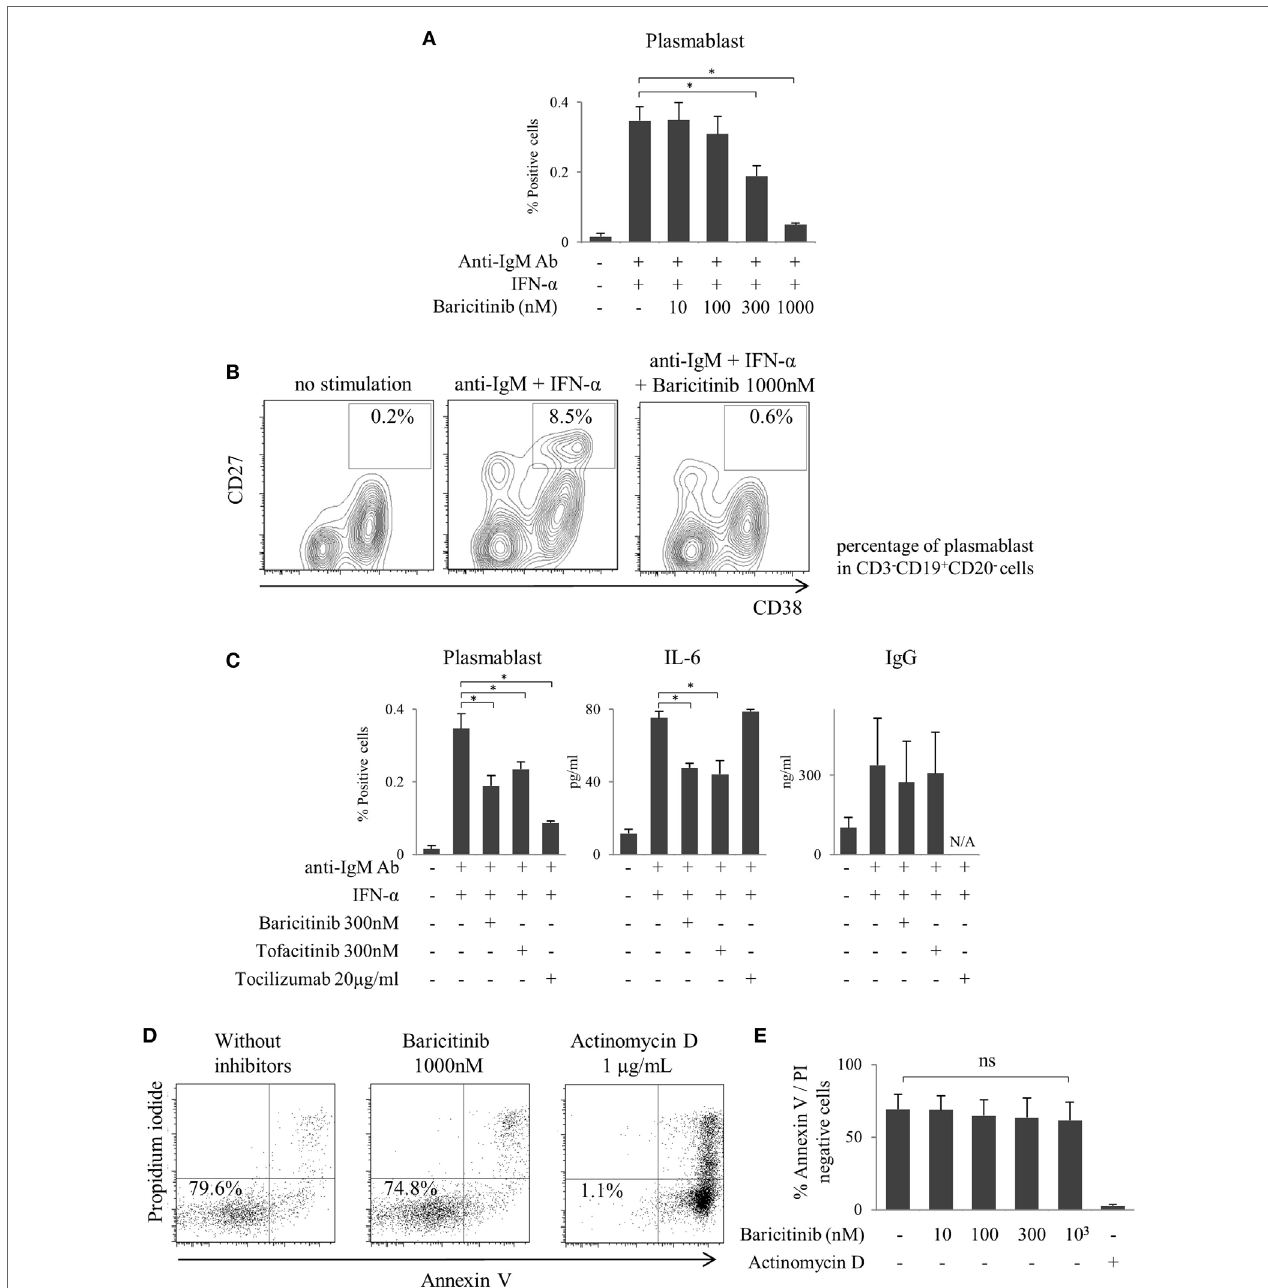
FigUre 4 | Baricitinib inhibits B cell differentiation. Human B cells were purified and cultured for 5 days in the presence of anti-human IgM Ab F(ab ′ )2 fragments and under interferon (IFN)- α stimulation. Plasmablast (CD3 − CD19 + CD20 − CD27 hi CD38 hi ) differentiation was assessed by flow cytometry, and IgG Ab titers and interleukin (IL)-6 concentrations in culture supernatants were measured by ELISA Cytometric Bead Array. (a) Percentage of plasmablasts. (B) Representative flow cytometry plots showing plasmablasts. (c) Percentage of plasmablast, IL-6, and IgG concentrations in the presence of baricitinib and other inhibitors. (D) Representative histogram data of annexin V/propidium iodide staining. (e) Rate of viable cells (annexin V neg /propidium iodide neg ). Data are mean ± SD of three different donors per group. * p < 0.05 (by Mann–Whitney U